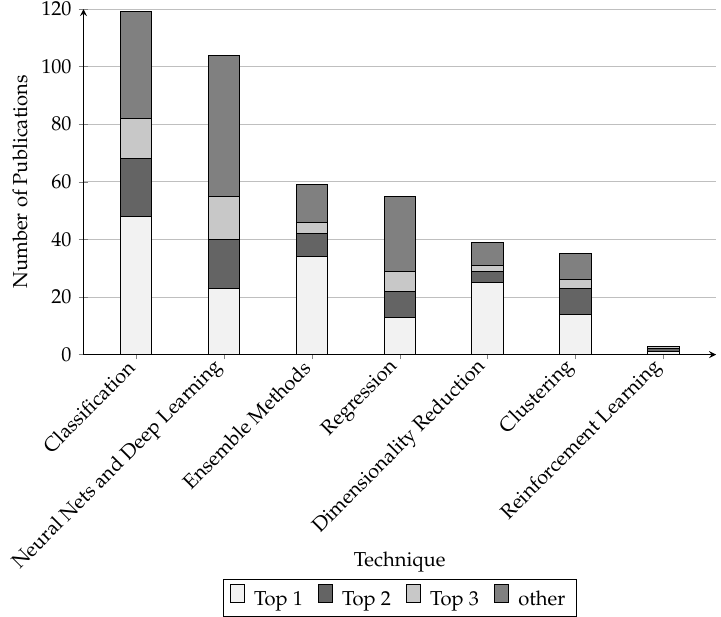
Figure 8. Techniques and top three algorithms.